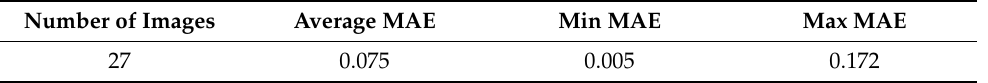
Table 9. Mean absolute error (MAE) of false-negative images in the Cityscapes dataset.